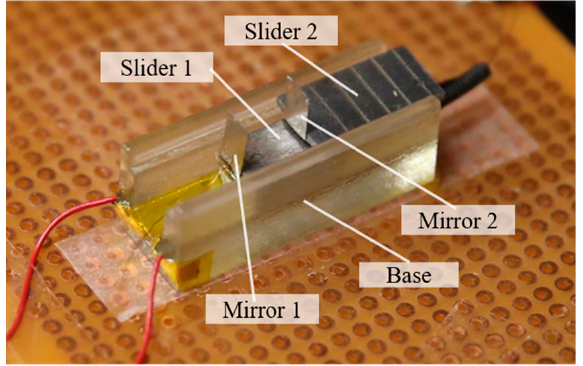
Figure 9. Prototype of the proposed actuator.